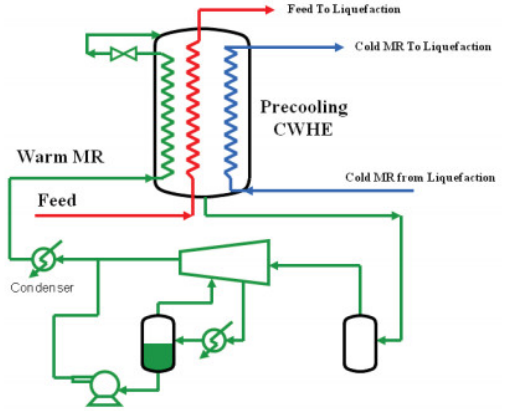
Figure 40. Single Pressure DMR Precooler with Liquid Pump-around [161]. Reproduced with permission from Elsevier (license number 5413520454256).